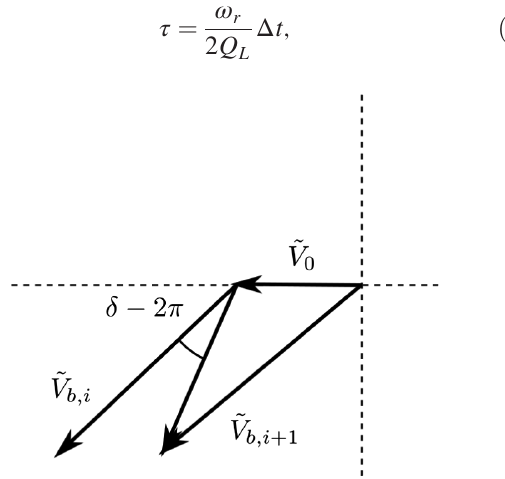
FIG. 1. Phasor addition of beam induced